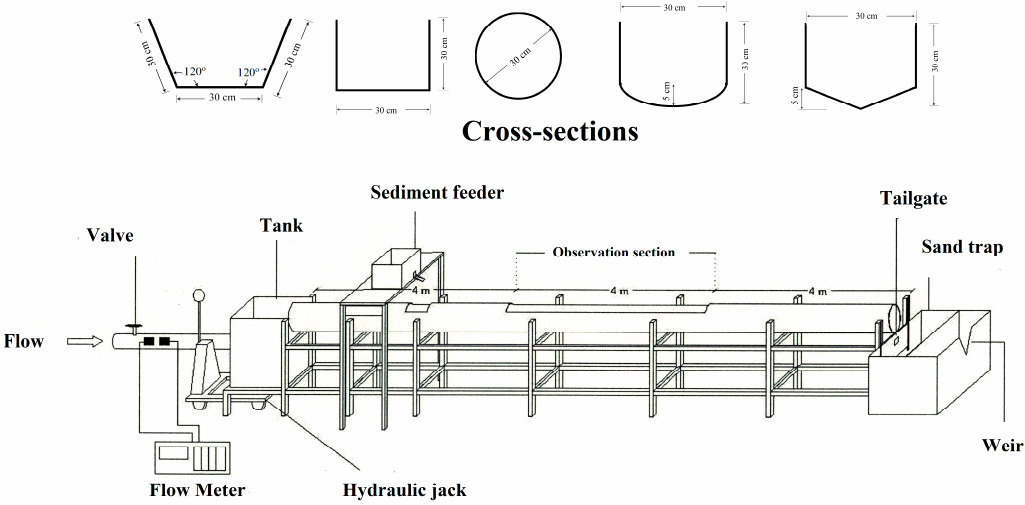
Figure 1. Experimental setup and cross-sections of the channels.